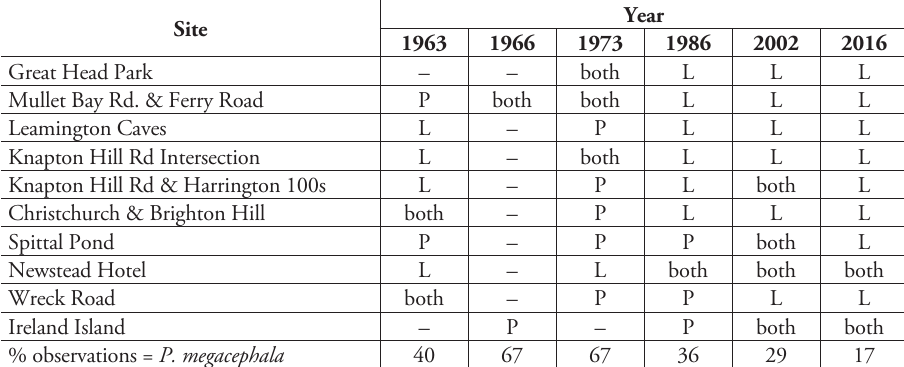
Table 2. Ten sites surveyed repeatedly by Haskins and Haskins (1988), Wetterer and Wetterer (2004), and the present study in 2016. P = Pheidole megacephala , L = Linepithema humile , both = both species, - = not surveyed. (See Methods for more detailed site